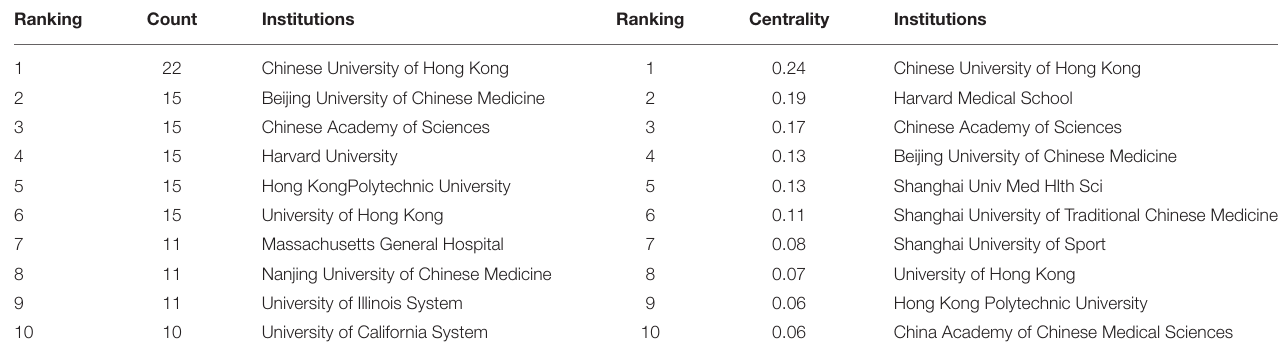
TABLE 3 | Top 10 institutions in terms of publications and centrality from 2001 to 2020.